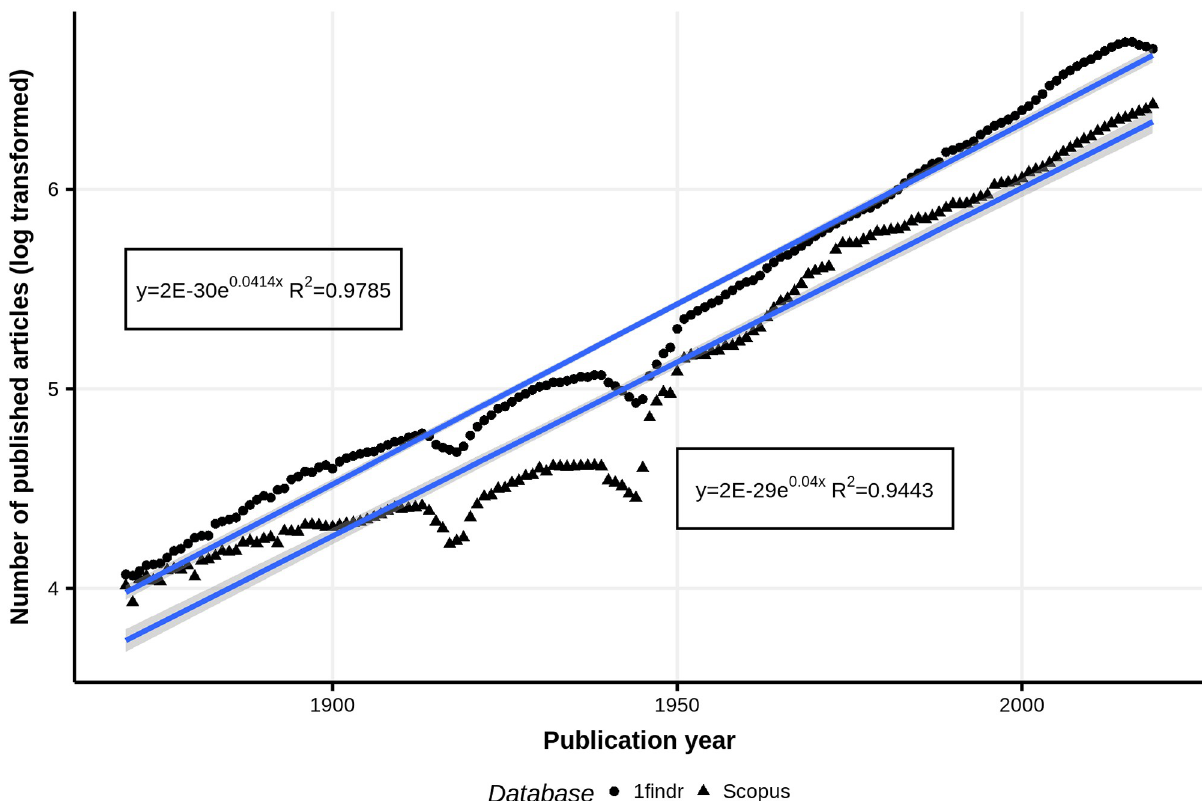
Fig 1. Growth of scientific articles published in scholarly journals, 1870–2015.